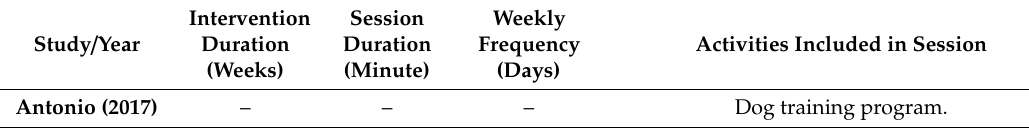
Table 3. Frequency, duration, and activities of the dog-based AAI